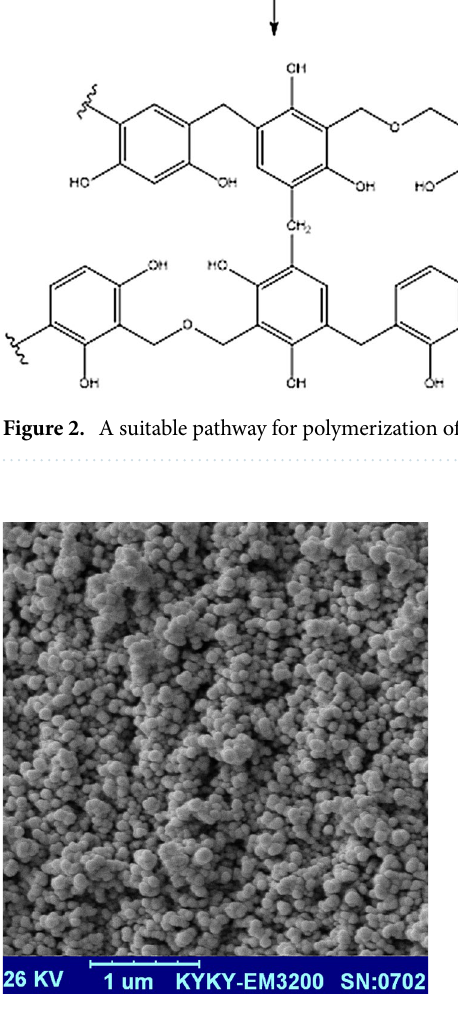
Figure 3. SEM image of the Fe 3 O 4 @Void@m.SiO 2